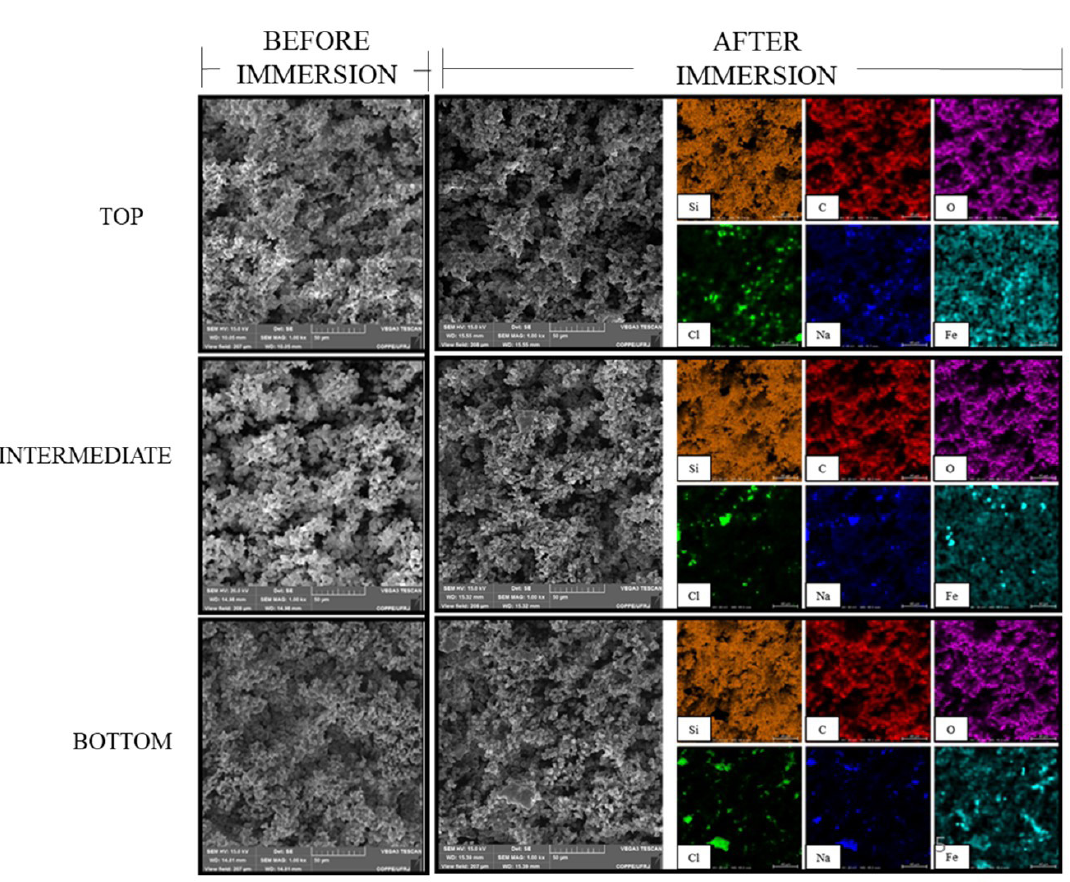
Figure 5. SEM images before and after immersion and elemental mapping of the superhydrophobic coating after immersion, considering three different regions (top, intermediate and bottom) of the sample surface.